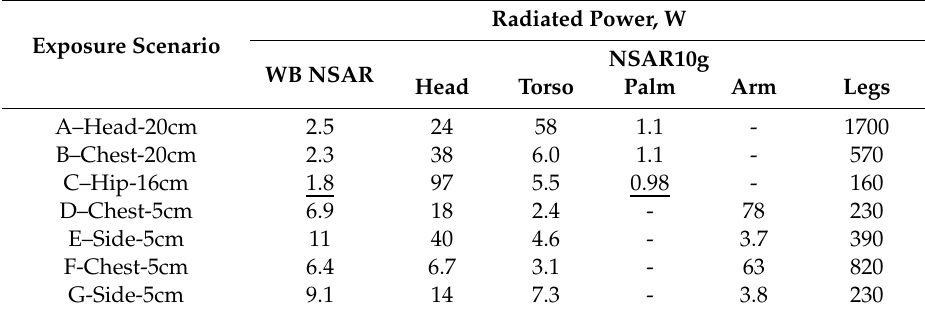
Table 5. The level of EMF emission, at 856 MHz from a UHF RFID reader, which causes SAR values in users or bystanders equal to general public limits in the considered exposure scenarios (6 min of continuous